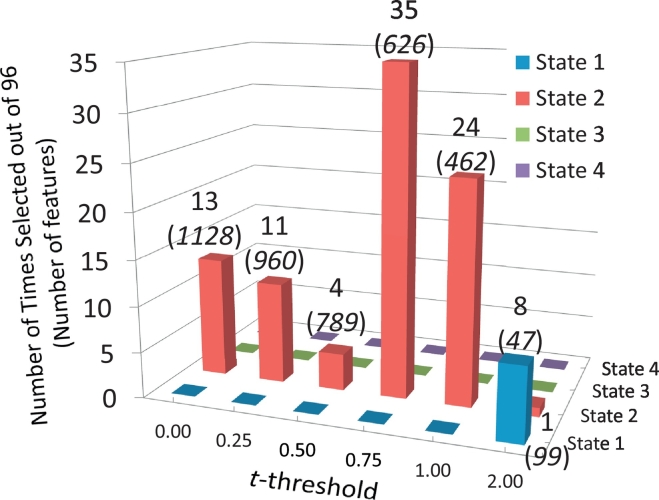
Histogram of classification performance (AUC) obtained using the nested loop of Fig. 3. State 3 and State 4 were never selected to classify the left out sample. State 2 was selected 88 times with the t-threshold of 0.75 as the preferred choice. State 1 was the second choice, which in most cases replaced missing subject data in State 2. The number of features is displayed in parenthesis below the number of times selected.